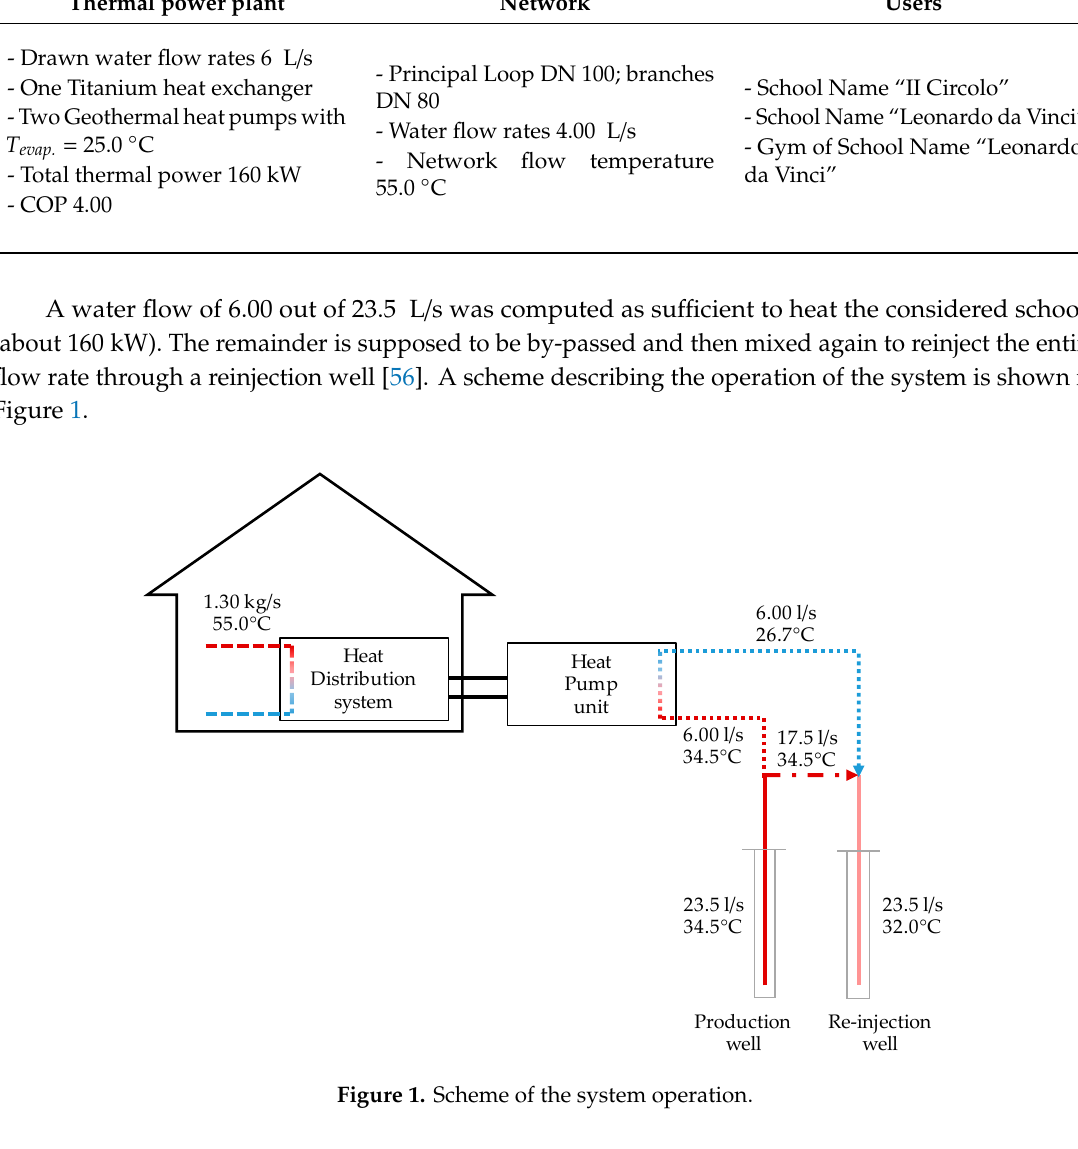
Table 1. The proposed system for the feeding of two public schools.